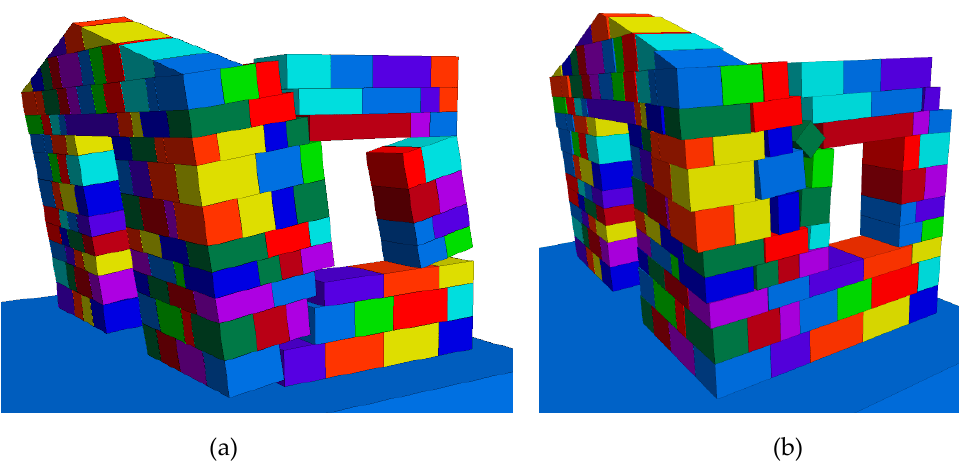
Figure 9. Numerical model configuration: ( a ) pushover failure mechanism; ( b ) final configuration at end of dynamic analysis.